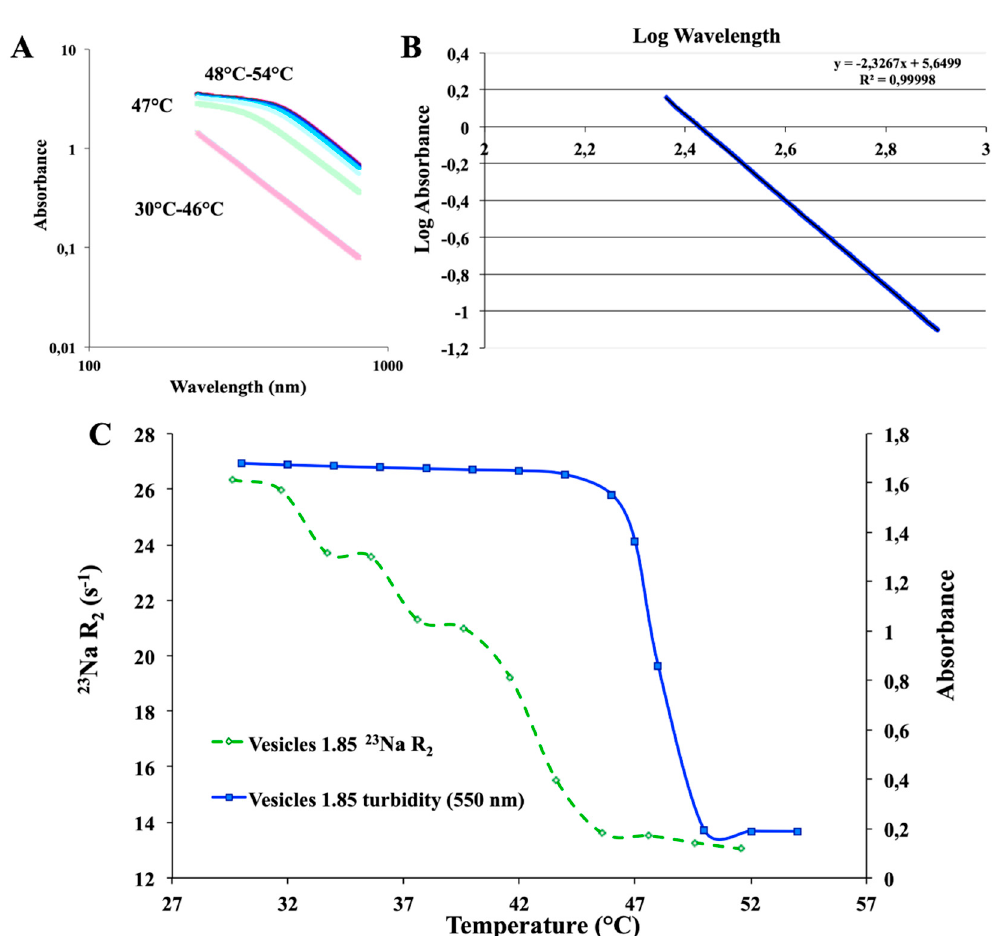
Figure 13. ( A ) UV-Vis spectra of an SDS / CTAB vesicles solution from 30 °C to 54 °C; ( B ) log/log plot of absorbance vs. wavelength; ( C ) comparison of turbidity and 23 Na transverse relaxation rates of SDS / CTAB system.